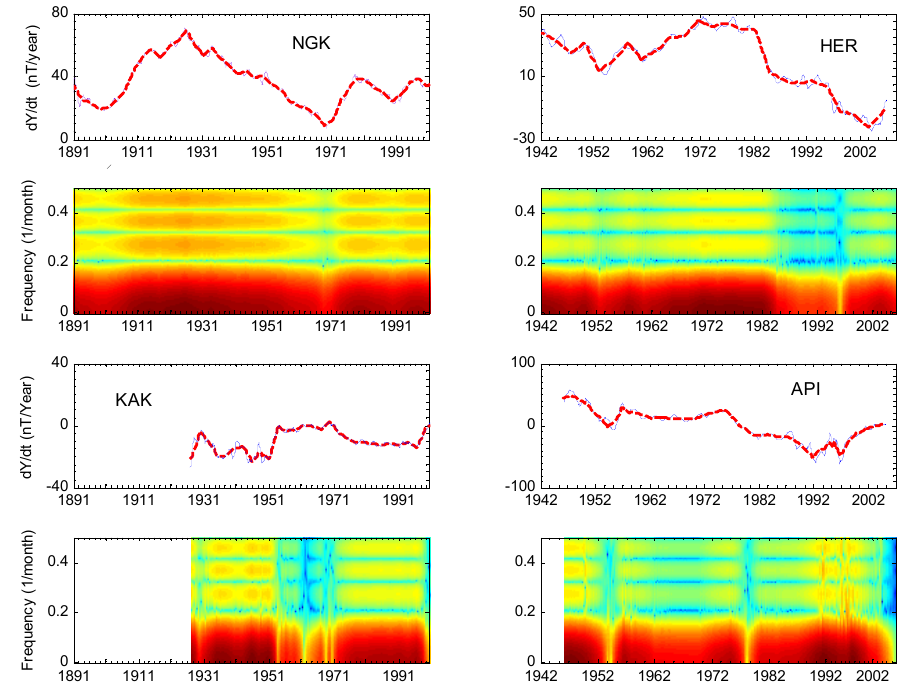
Fig. 6. The signals (blue curves) and de-noised signals (red curves) of secular variations (SV y = dY/dt) of NGK, KAK, API and HER observatories and their respective spectrograms.